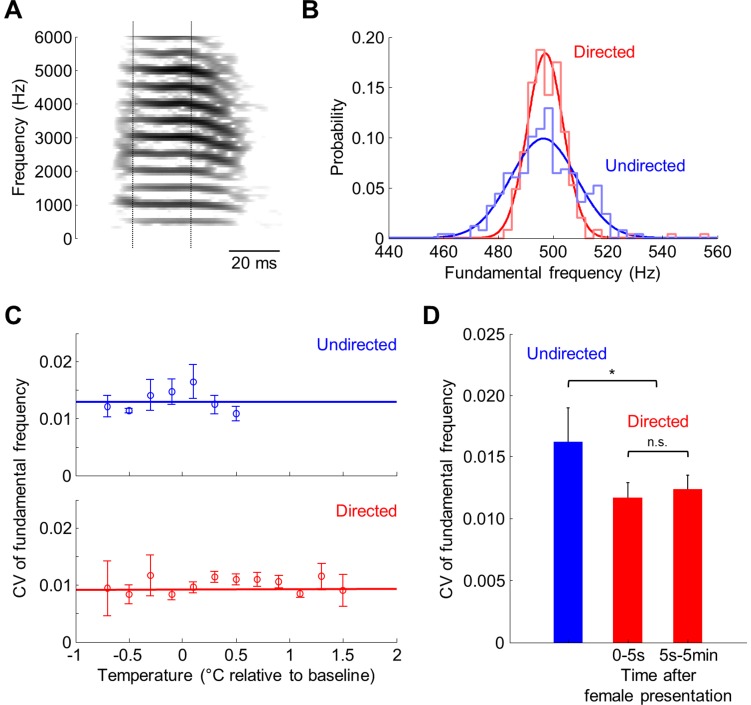
Acoustic variability is not correlated to brain temperature.(A) Spectrogram of a syllable from bird #7 that contained a harmonic stack and was used for the calculation of fundamental frequency. Dotted lines indicate the automatically detected time interval on which fundamental frequency was calculated. (B) Distributions of fundamental frequency across all directed (red) and undirected (blue) renditions of the harmonic stack shown in (A). Gaussian fits to both distributions are also shown. Note that harmonic stacks during directed singing exhibit less variability. (C) Variability of fundamental frequency measured across different temperature values. All harmonic stacks were sorted into temperature bins (0.2°C wide); the coefficient of variation of the fundamental frequency (CV, standard deviation/mean) was measured within each bin. Lines are linear fits to the data. Baseline temperature is the average temperature recorded during all undirected motifs. (D) CV of the fundamental frequency for all undirected (blue) and directed (red) songs. For directed song, harmonic stacks are separated into those produced within 5 s after the presentation of a female and those produced after 5 s. Note that the variability is already reduced in songs produced immediately upon presentation. In (C) and (D), data shown are average CV values across harmonic stacks from 8 different syllables in 5 birds for directed songs and 7 syllables in 4 birds for undirected songs; error bars are SEM across harmonic stacks.